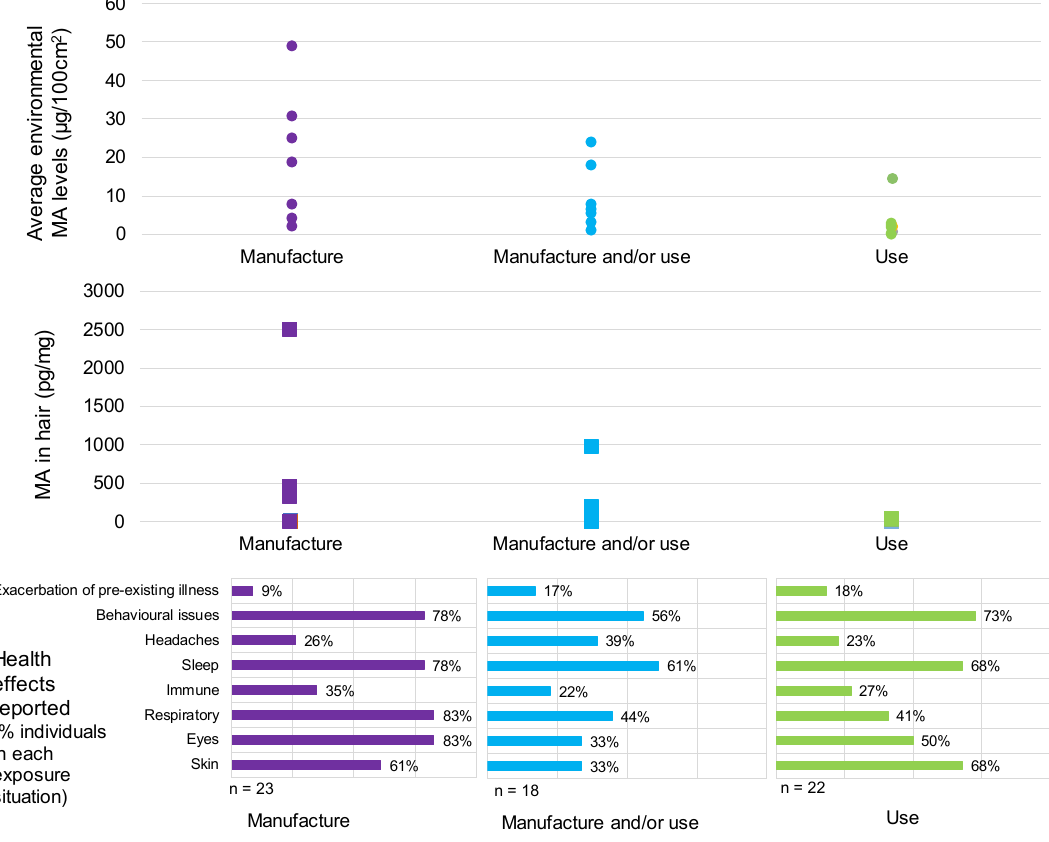
Figure 4. Summary of exposure and health data by exposure situation for manufacture and use.